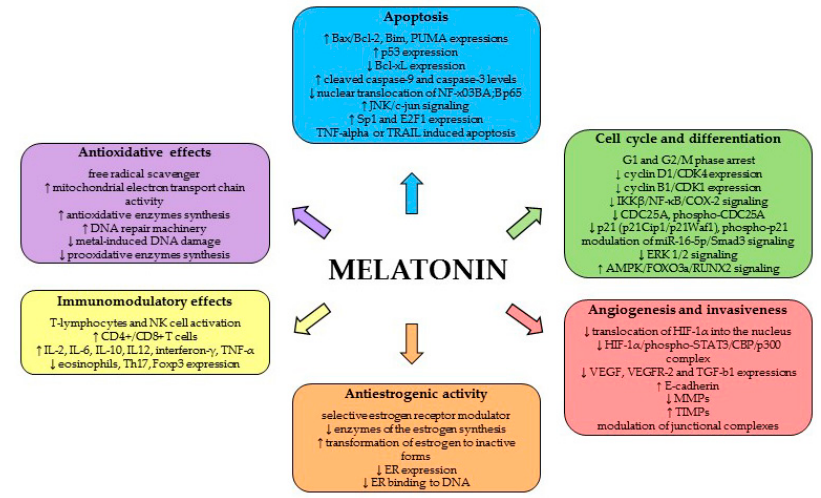
Figure 2. Oncostatic mechanisms of action of MEL.